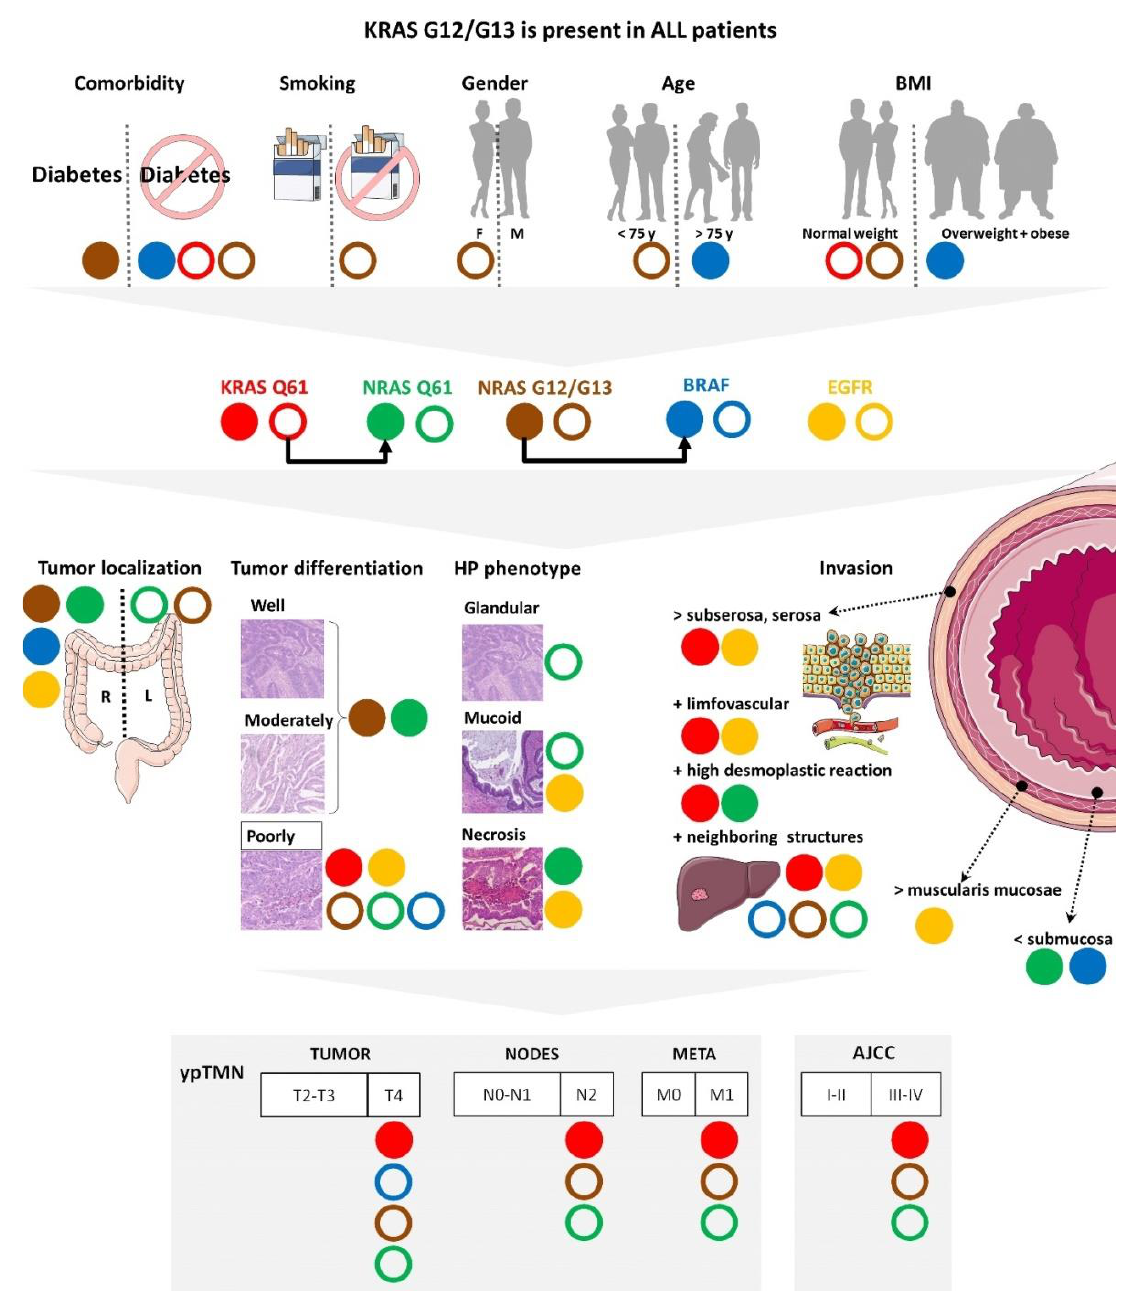
Figure 4. Integrative diagram of the most significant findings. These associations were evaluated considering the separate presence and absence of each of the studied mutations (labelled in different colors). The filled circles signify the association with the mutation ’s presence (AF‰ ≥ 0.1), while the empty circles indicate the association with the mutation ’s absence (AF‰ = 0). In the upper register, we considered that the mutation ’ s presence or absence is correlated with the absence or presence of a risk factor. The significant associations between the KRAS Q61 and NRAS Q61 mutations, on the one hand, and between the NRAS G12/G13 and BRAF mutations, on the other hand, are represented by the black arrows. Thus, the first black arrow shows that the absence of the KRAS Q61 mutation is significantly associated with the presence of the NRAS Q61 mutation. Also, the second black arrow shows that the coexistence of NRAS G12/G13 and BRAF mutations is statistically significant. In the lower register, we resumed the important associations between mutational status and the histopathological characteristics and CRC staging.